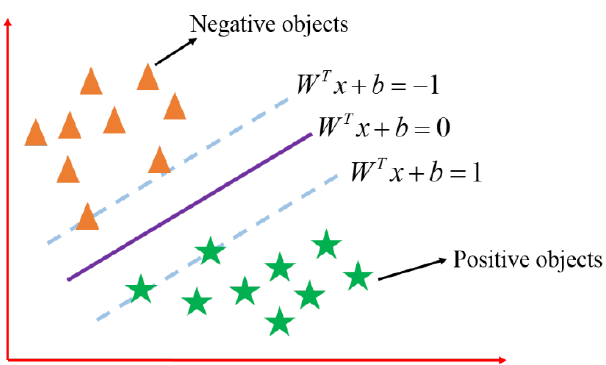
Figure 7. Schematic diagram of support vector